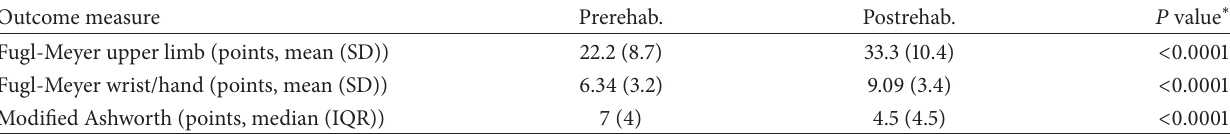
Table 2: Gains in muscle function outcome measures from pre- to postrehabilitation.